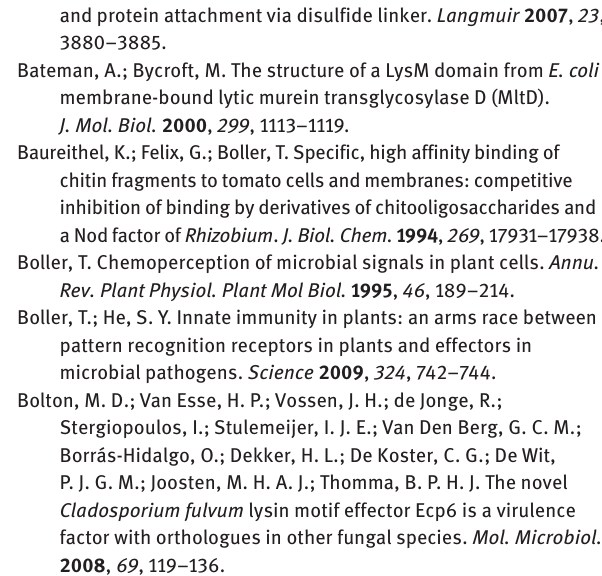
Figure 11. The loss of crops due to pathogens has spurred the advances in this field toward a better understanding of these interactions. By expanding the field of